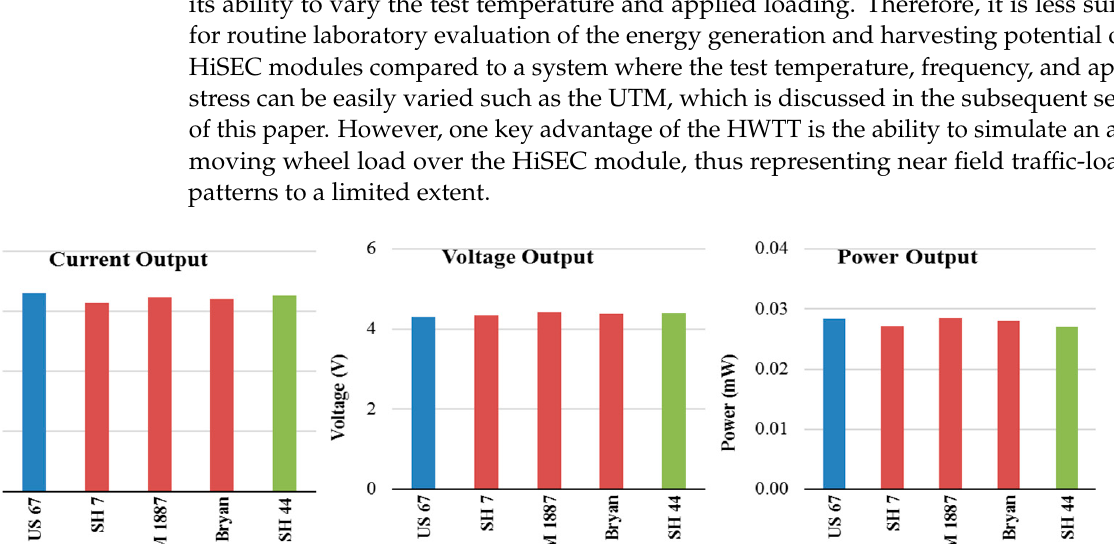
Figure 5. HMA Moduli Values at 5 Hz.